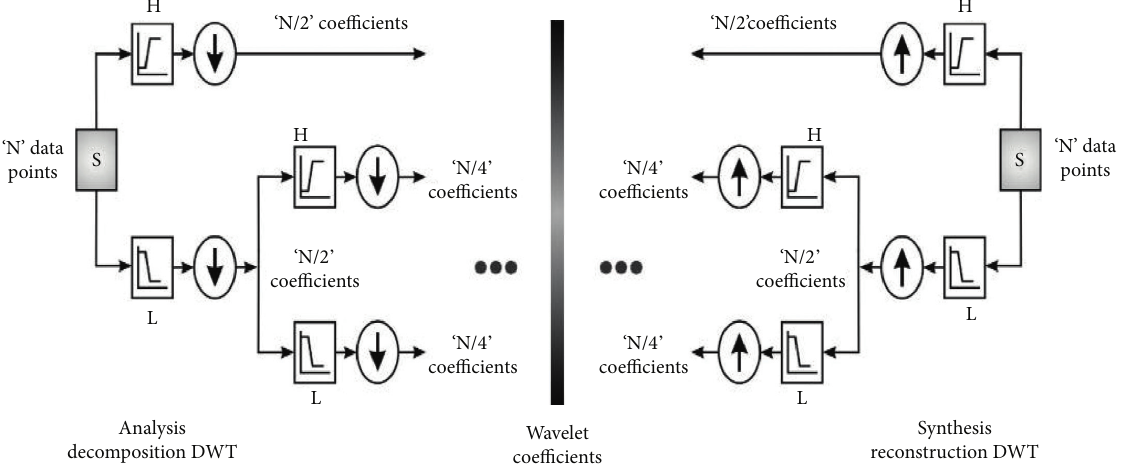
Figure 2: Wavelet study carried upon decomposition/synthesis and reconstruction through